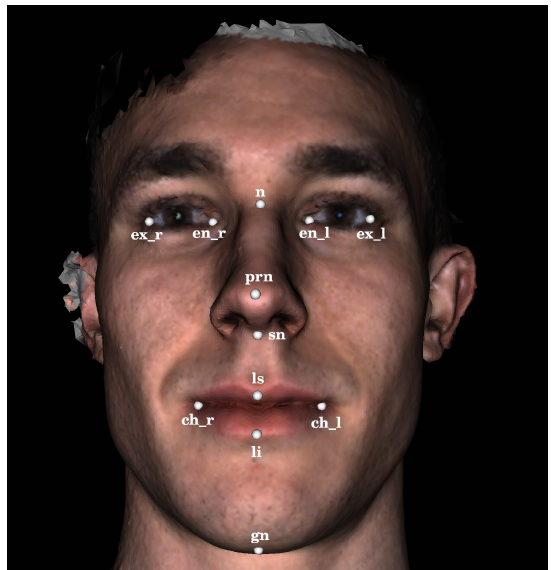
Figure 3. A facial surface scan annotated with the twelve 3D landmarks used in this study. The 3D landmarks were identified by projecting a subset of the 2D landmarks shown in Figure 4 onto the surface scan using a ray casting algorithm.